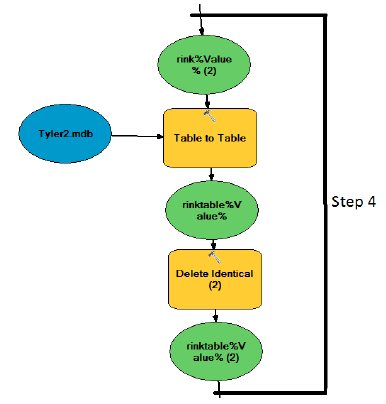
Figure 5: Step 4: preparation for seat